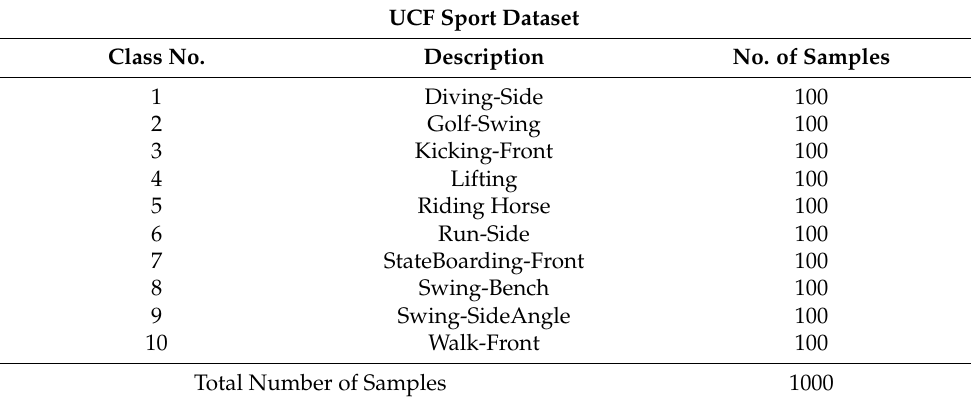
Table 2. Details of UCF Sport dataset.